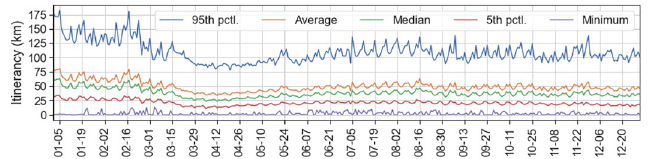
Fig 1. Daily itinerancy aggregation measures in California throughout 2020. Itinerancy averages for each block group are further aggregated over the entire state in five different measures to show the range of variation. Major mobility trends are apparent in all aggregation measures except for the minimum. For the remainder of this analysis, the median is used for mobility except where otherwise